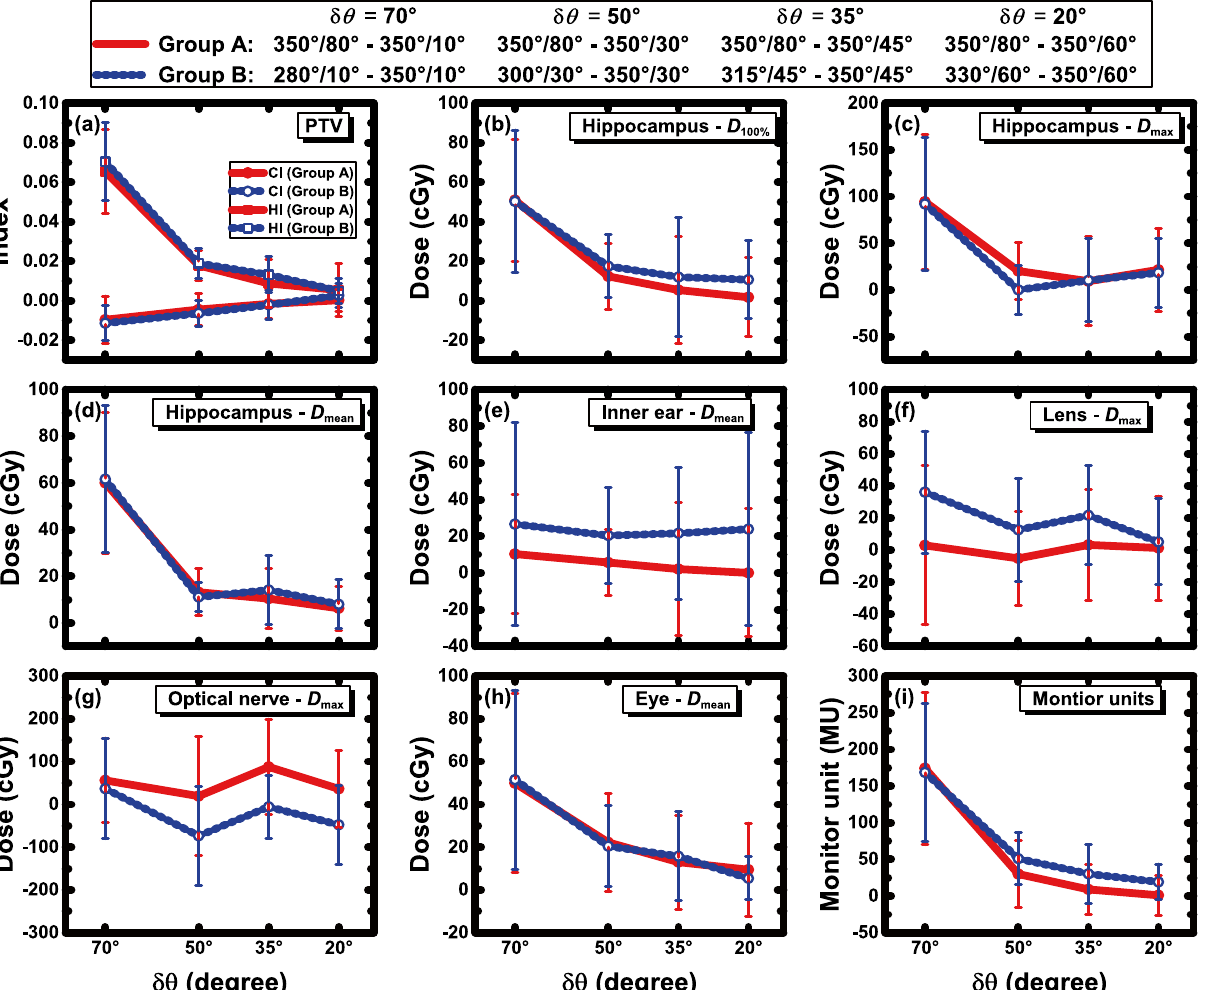
Figure 2. Variation of parameter differences between Δ θ < 90° plans and Δ θ = 90° plans with respect to δ θ (= 90° − Δ θ ). Group A shows the differences between plans with the same arc 1 collimator, indicated by the filled symbols and solid lines. Group B shows the differences between plans with the same arc 2 collimator, indicated by the open symbols with dashed lines.